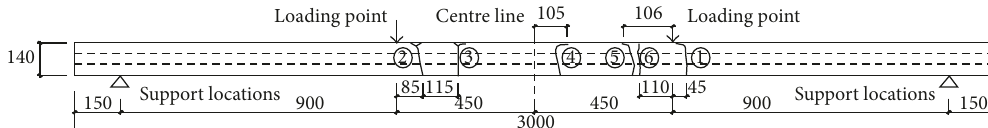
Figure 24: Failure mode of GB-5.